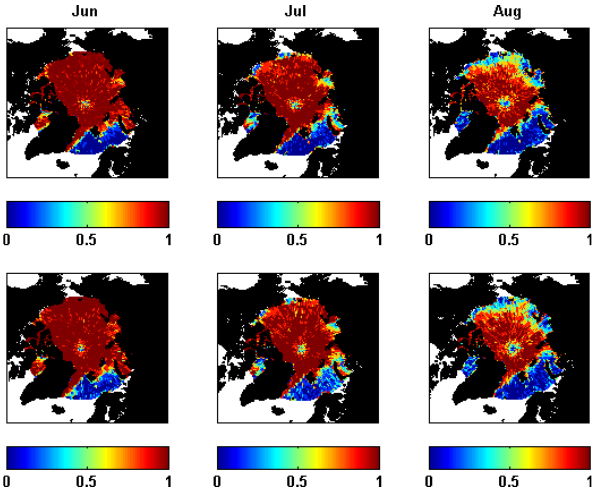
Fig. 2. Same as in Fig. 1, but for the winter